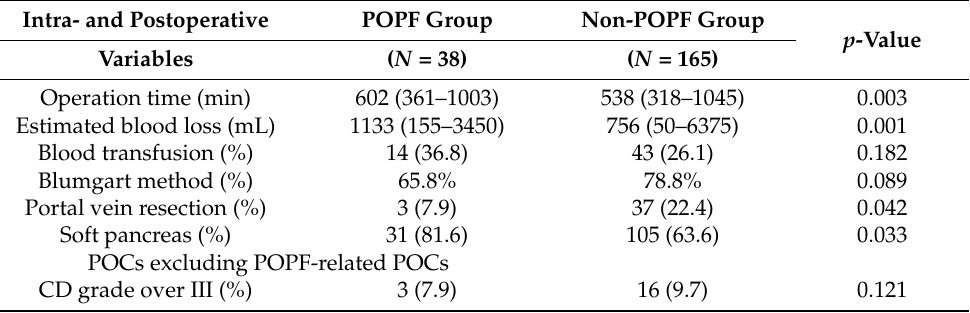
Table 2. Intra- and postoperative variables in patients with and without postoperative pancreatic